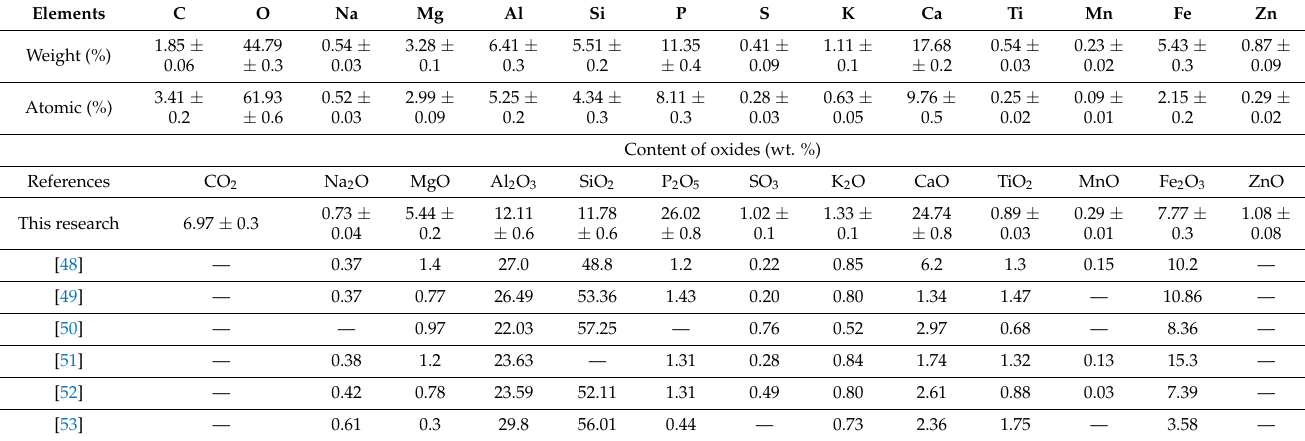
Table 1. Elemental composition of SS-FA (EDS microanalyzer) and comparison with the literature. Elements